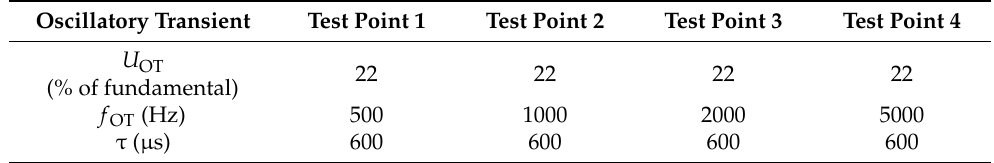
Table 10. Proposed test point for oscillatory transient. Oscillatory